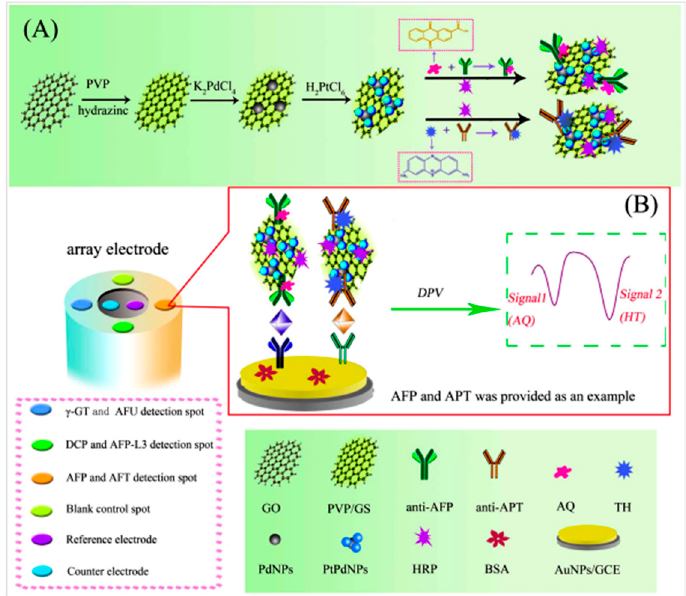
Figure 7. Preparation of HRP/PtPd/GS labeled redox probe branched antibodies ( A ). ( B ) Stepwise immunosensor fabrication process and DPV electrochemical responses. Reprinted from Ref. [12] with permission.